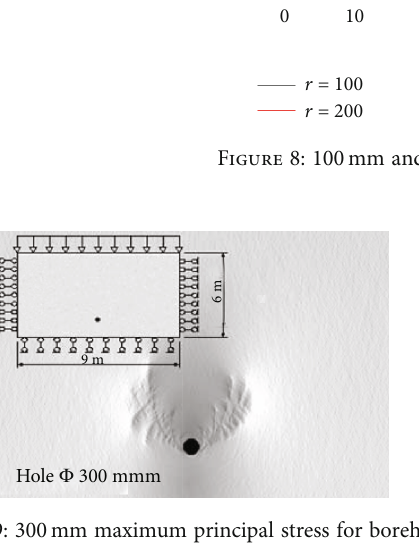
Figure 8 indicates the comparison curve of the fl ow change process of 100-mm and 200-mm diameter boreholes.